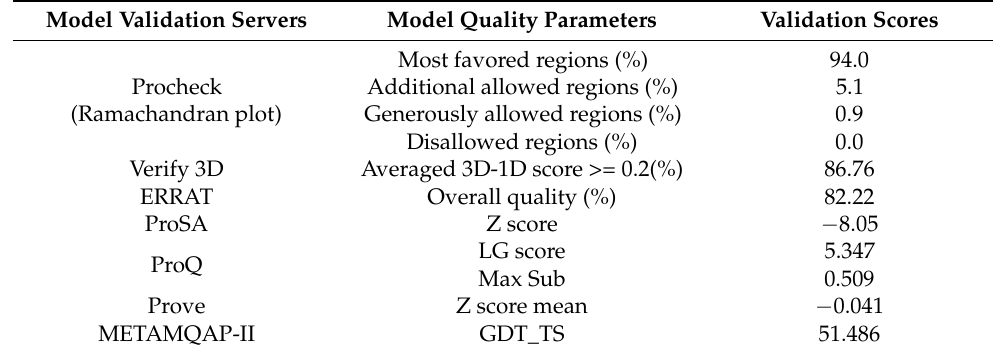
Figure 2. Ramachandran plot and ProSA z-score analysis of the modeled G-alpha subunit of Triticum aestivum . ( A ) The Ramachandran plot was generated using Procheck tool embedded in SAVES and the z-score plot was plotted using ProSA-Web ( B ). Table 1. Model validation statistics of G-protein alpha subunit of Triticum aestivum using various structural evaluation